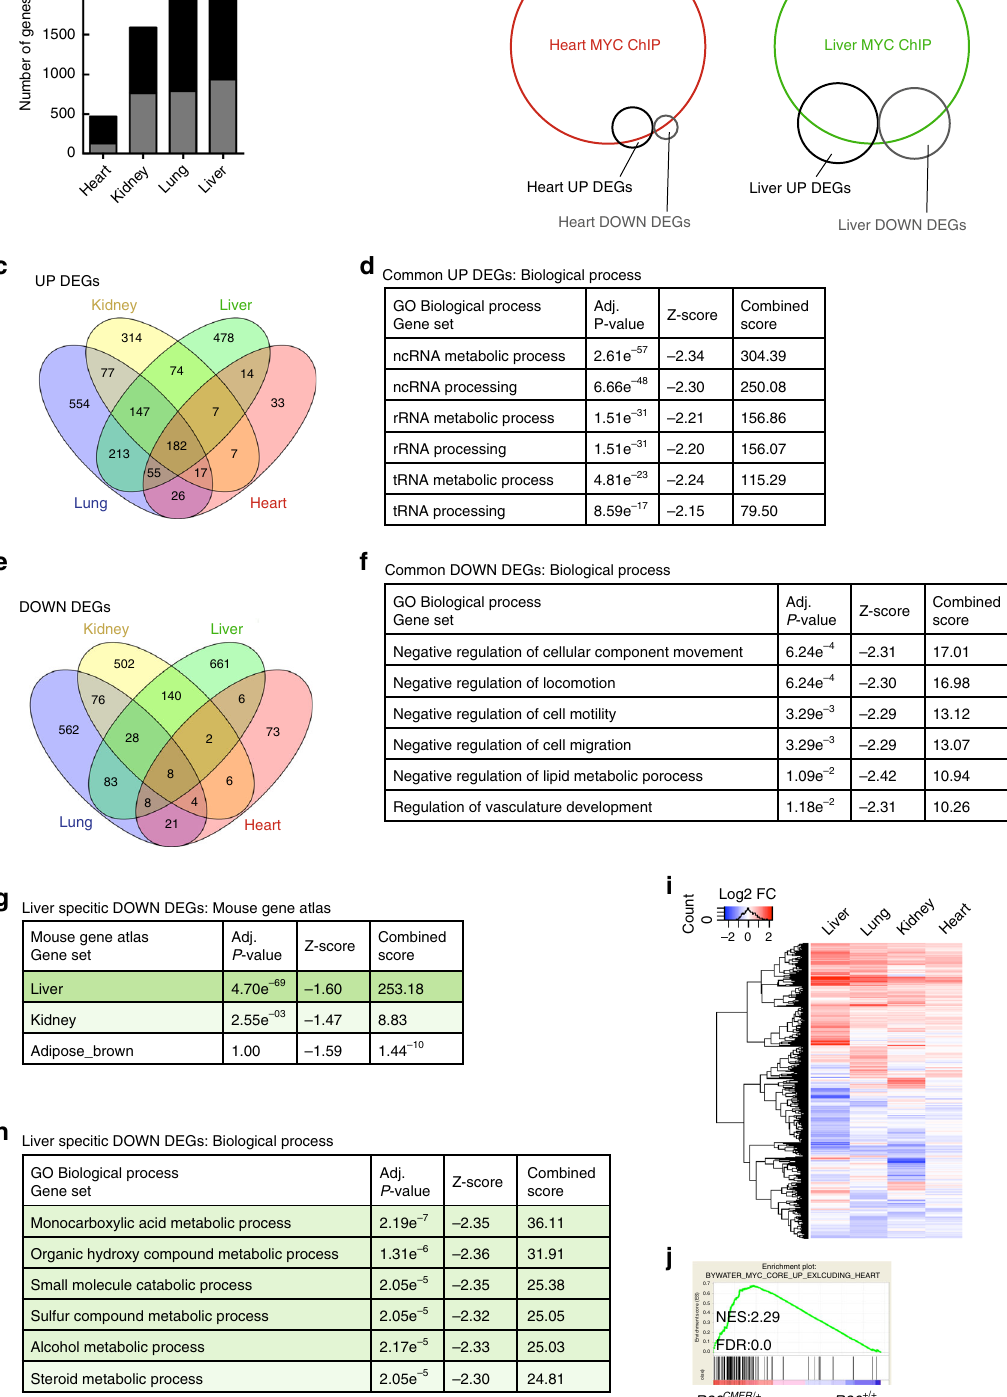
Acute MycER activation in the presence of overexpressed Cyclin T1 induced the transcription of a panel of common Myc target genes normally up-regulated by Myc in the liver but not in the adult heart (Fig. 8c, Supplementary Fig. 8a). RNA sequencing indicated a pro fi cient global transcriptional response to the activation of Myc in the presence of ectopic Cyclin T1 in the adult heart or puri fi ed